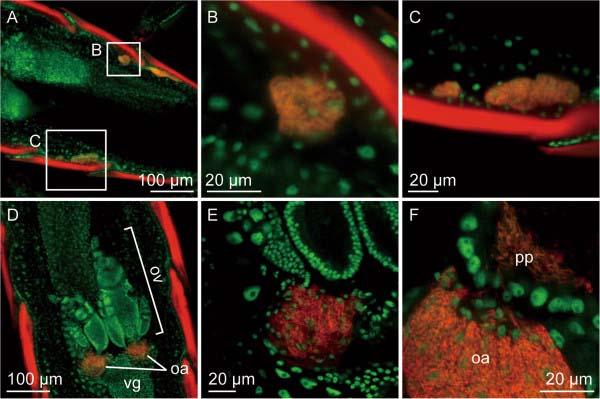
Fluorescent in situ hybridization of C. baculoides symbiont cells. (A) Abdominal image of an adult male. Signals of the symbiont cells are detected in bacteriocyte clusters located on both sides of the abdominal body cavity. White squares indicate the areas of panels B and C. (B, C) Enlarged images of the bacteriocyte clusters in panel A. Signals of the symbiont cells are localized in the cytoplasm of the bacteriocytes. (D) Abdominal image of an adult female. Signals of the symbiont cells are localized in ovarial ampullae located at the base of the ovaries. (E) An enlarged image of an ovarial ampulla. (F) A snapshot of symbiont transmission from an ovarial ampulla to a developing oocyte. Red and green signals indicate symbiont 16S rRNA and host nuclear DNA, respectively. Abbreviations: oa: ovarial ampulla, ov: ovariol, vg: vagina, pp: posterior pole of oocyte.